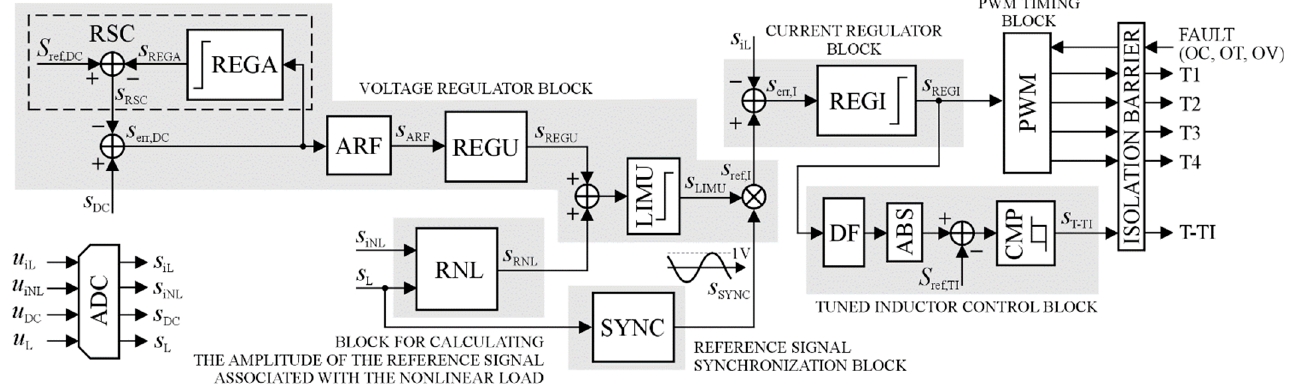
Figure 6. Block diagram of the power supply control section.